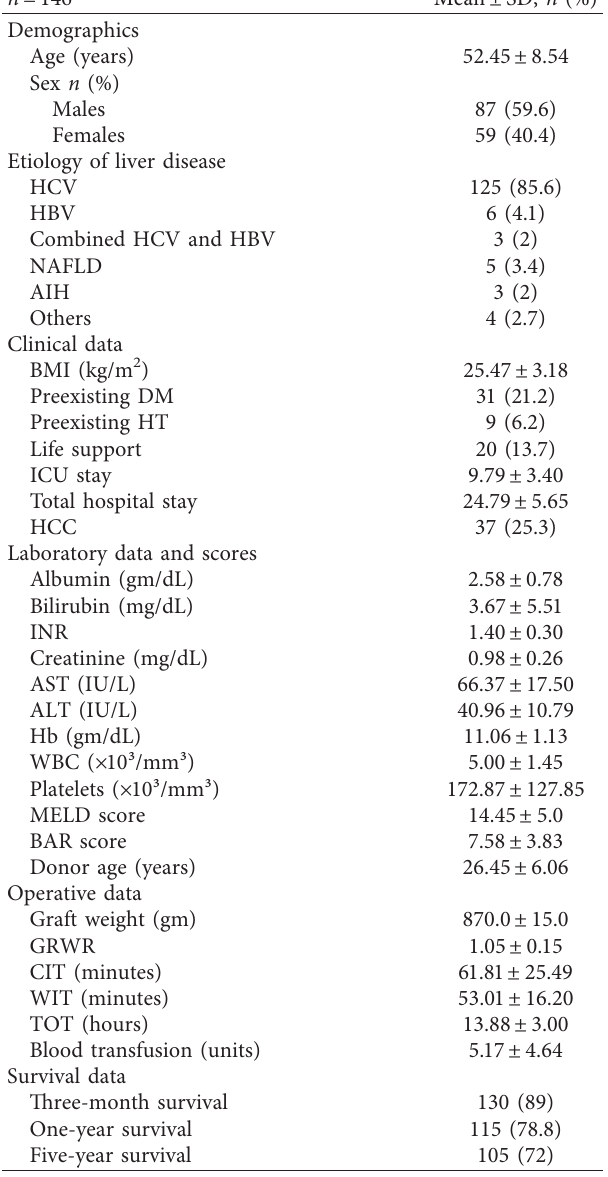
Table 1: Demographic, clinical, laboratory, operative, and survival data.